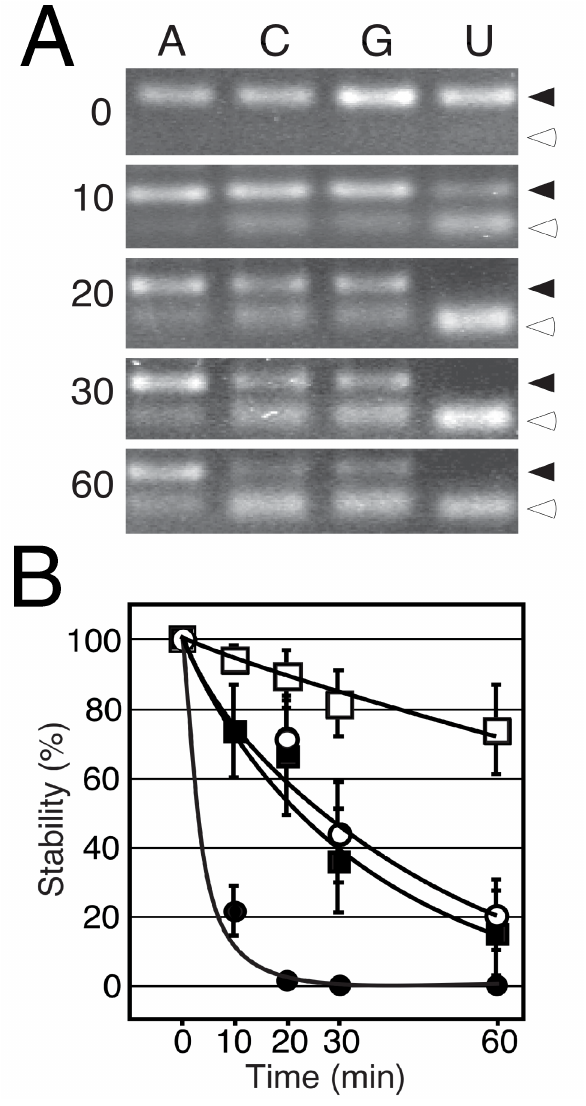
Figure 3. The RNase susceptibility of wild-type and mutant A. ful- gidus SRP RNA helices 6 and 8 (AfRH68) RNAs. (A) The nature of the nucleotide residue (A, C, G or U) at position 159 of A. fulgidus SRP RNA (AfSR) is indicated on top. Numbers on the left show the incubation time in minutes. Filled and open arrowheads indicate the undigested and RNase-cleaved AfRH68 products, respectively. (B) Quantitative analysis of the RNase susceptibility of wild-type AfRH68 ( (cid:2) ), A159C mutant RNA ( (cid:3) ), A159G mutant RNA ( (cid:4) ) and A159U mutant RNA ( (cid:5)